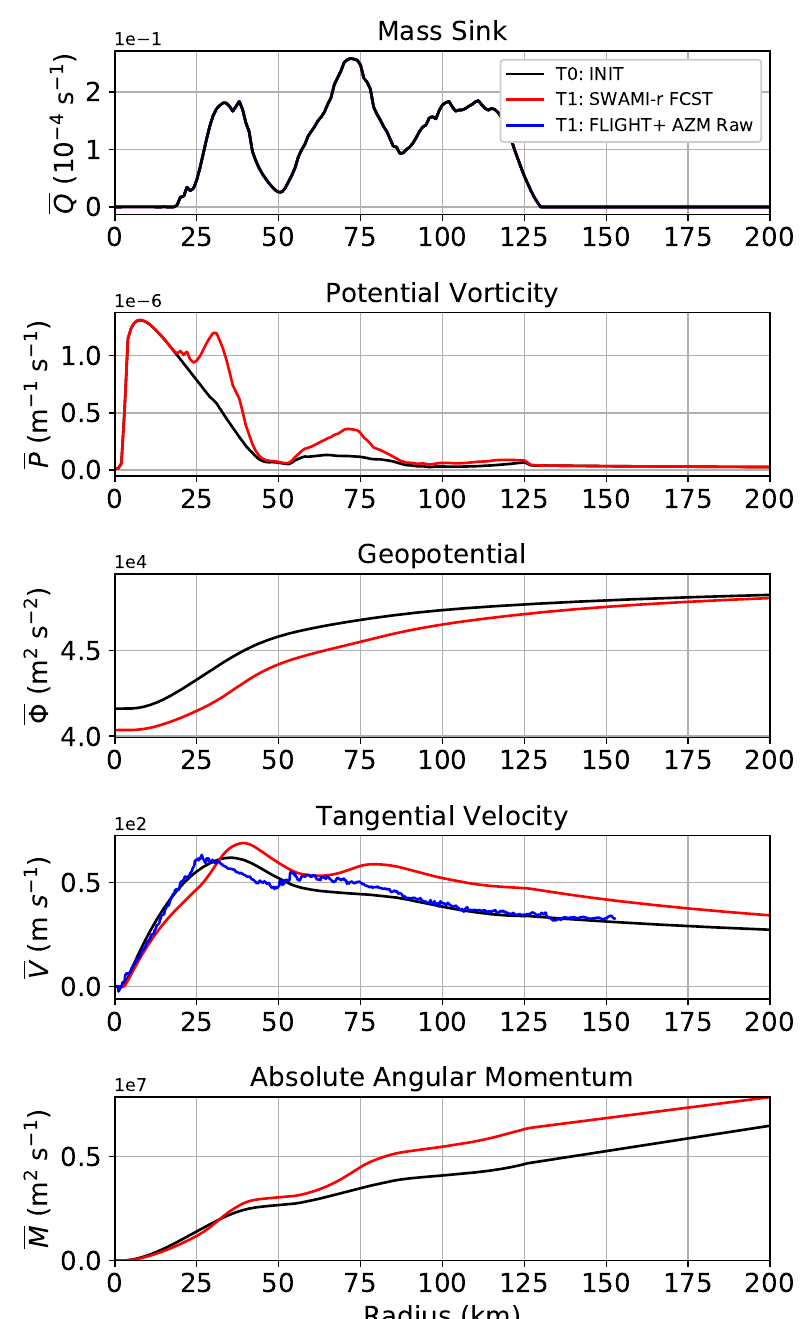
Figure 8. Secondary wind maxima formation event of Hurricane Irma from 7 September 2017 12:02:46 to 7 September 2017 23:54:20. The five panels show the SWAMI initialization and forecasts of PV , Φ , v , M , and the mass sink forcing Q . Verification of the SWAMI azimuthal mean tangential velocity using the 7 September 2017 23:54:20 azimuthal mean group is shown in the blue curve on the fourth panel. Note that this case is not an intensifying event and is not included in Table